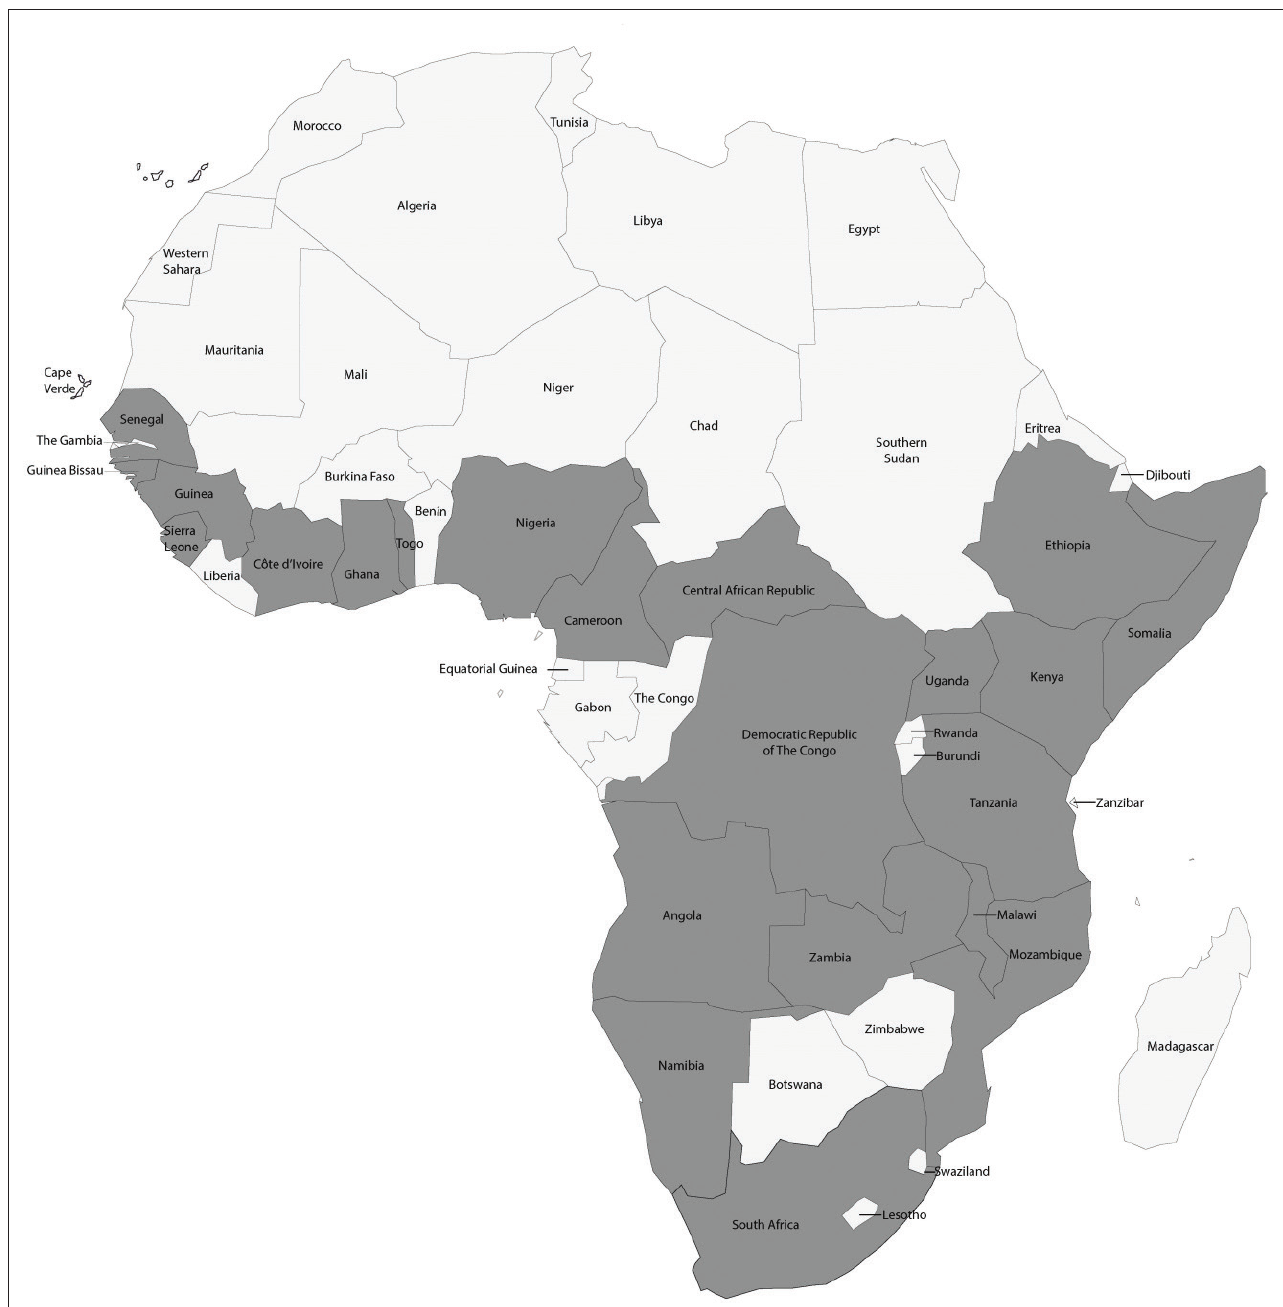
FIGURE 1: Map of Africa highlighting (with shading) countries where antimicrobial-resistant enteric bacterial pathogens have been isolated and further investigated using molecular subtyping